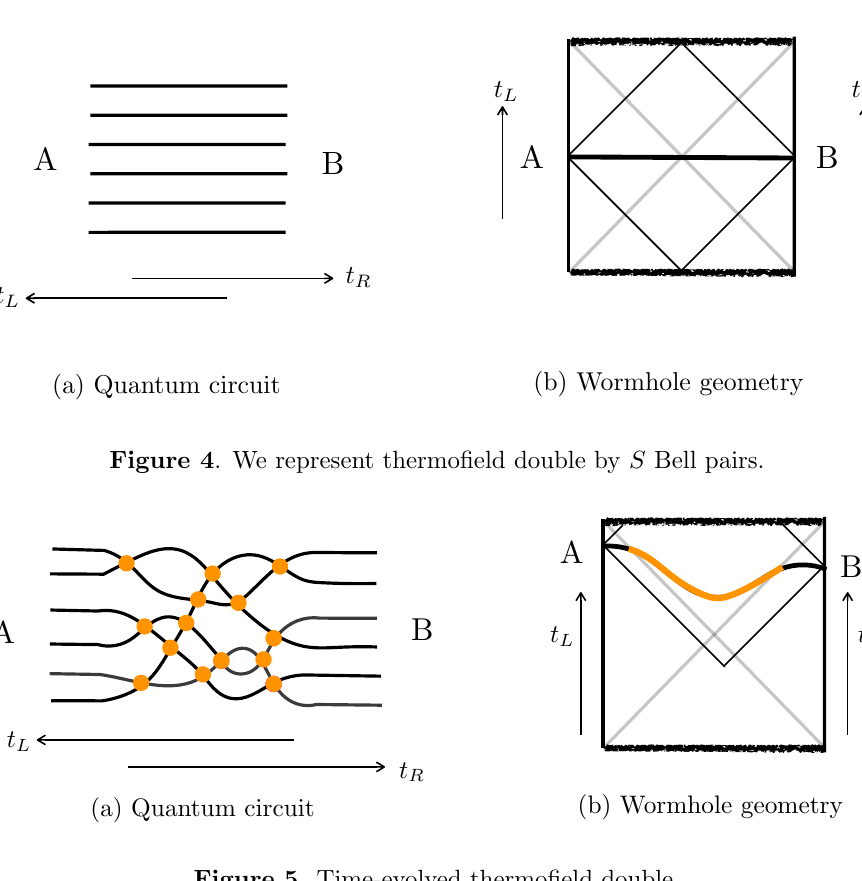
Figure 5 . Time-evolved thermo(cid:12)eld